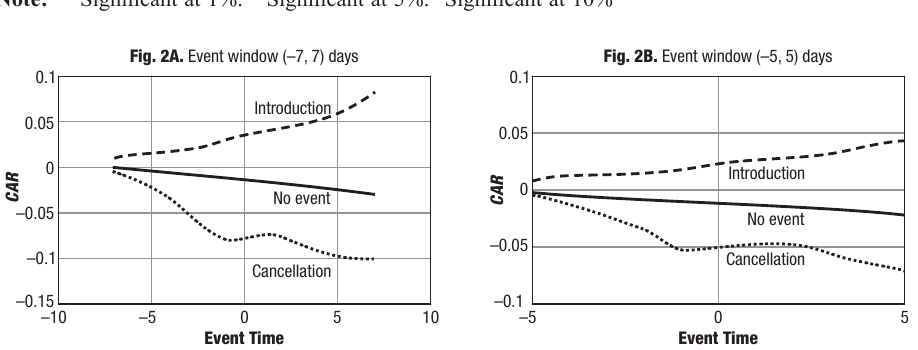
Fig. 2. CAR evolution versus event time fi ltering by M&A information